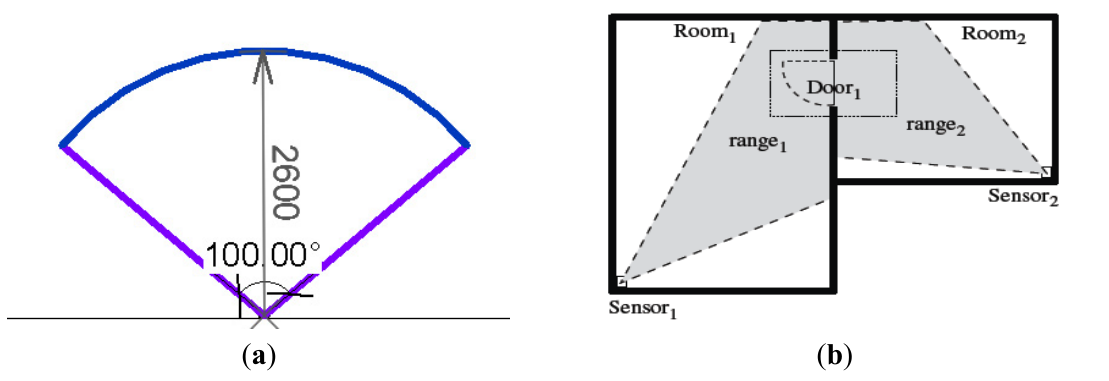
Figure 3. ( a ) Example of the range space of a sensor with range radius of 2.6 m and a range angle of 100°; ( b ) the door’s operational space should be within the range space of the two monitoring